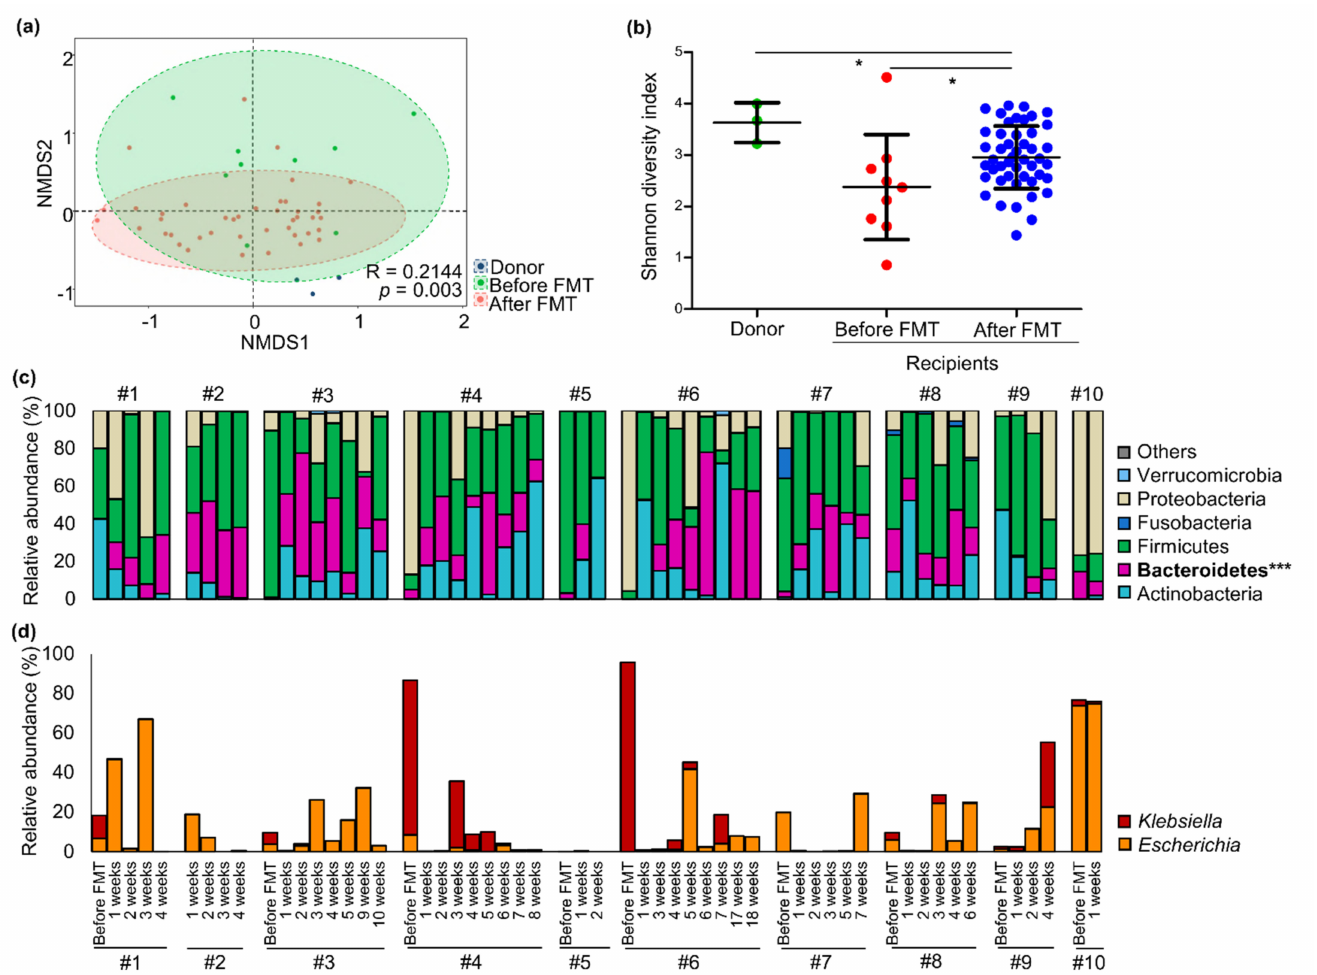
Figure 1. Gut microbiota changes in CRE carriers during FMT treatment. ( a ) The difference in microbiota between carriers and donors were compared in NMDS plots. ( b ) Shannon diversity indices of gut microbiota were compared among donor, carriers before FMT, and carriers after FMT. ( c ) Changes in phylum composition were compared in each carrier according to sampling times. ( d ) Changes in detected CRE genera, Klebsiella and Escherichia , were compared in each carrier according to sampling times. *** p < 0.001, * p < 0.05. CRE, carbapenem-resistant Enterobacteriaceae; FMT, fecal microbiota transplantation; NMDS, non-metric multidimensional